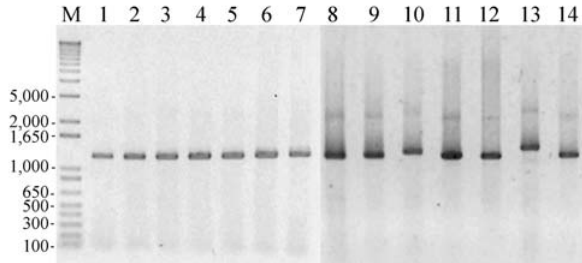
Figure 2 - 1% agarose gel of PCR-generated D-loop mtDNA fragments of Leporinus elongatus (1-8), Leporinus cf. elongatus (9), Leporinus obtusidens (10), Leporinus friderici (11-12), Leporinus desmotes (13), and Parodon tortuosus (14). M indicates 1Kb ladder for molecular weight